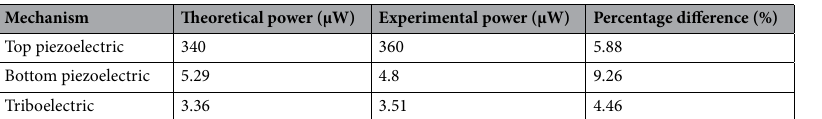
Table 5. Theoretical and experimental power from the top piezoelectric beam, bottom piezoelectric beam, and triboelectric mechanism of optimised MT-HPTEH.